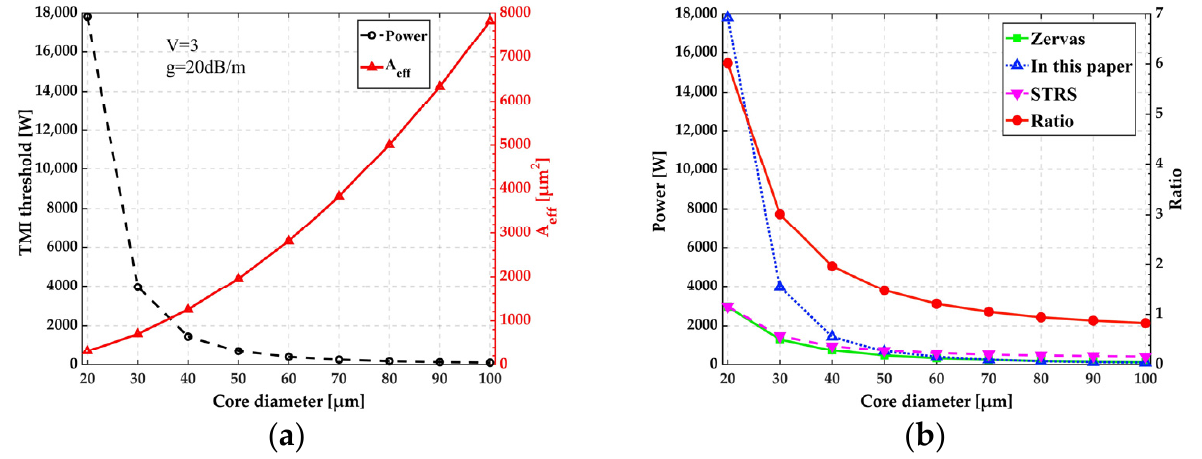
Figure 3. TMI threshold power (given by Equation (27)) and effective mode field area ( a ) as a function of core diameter, and ( b ) the TMI threshold in this work is compared with the reference [19].